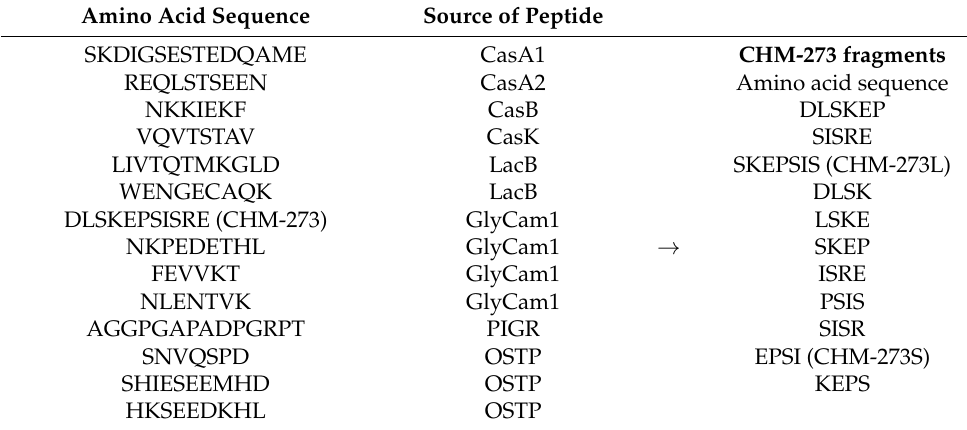
Table 1. The origin and amino acid sequences of the tested peptides. Amino Acid Sequence Source of